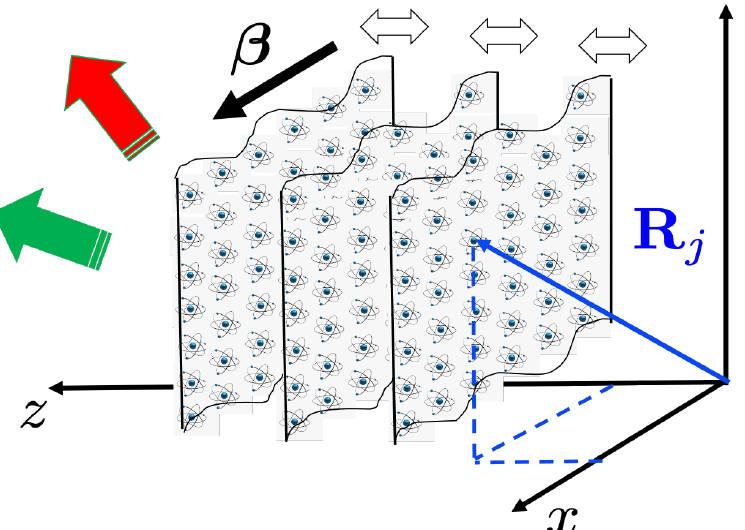
Figure 1. Concept of space–time motion-induced DCE. An atomic array is externally driven by a spatiotemporal modulation of their center-of-mass coordinates. Atoms oscillate along the z -direction and are temporally dephased by a linear synthetic phase distribution Φ ( R ) = β x . The modulation produces a traveling wave of ripples moving along the x -direction. Pairs of photons (red and green arrows) are emitted with in-plane linear momentum adding up to the momentum kick β